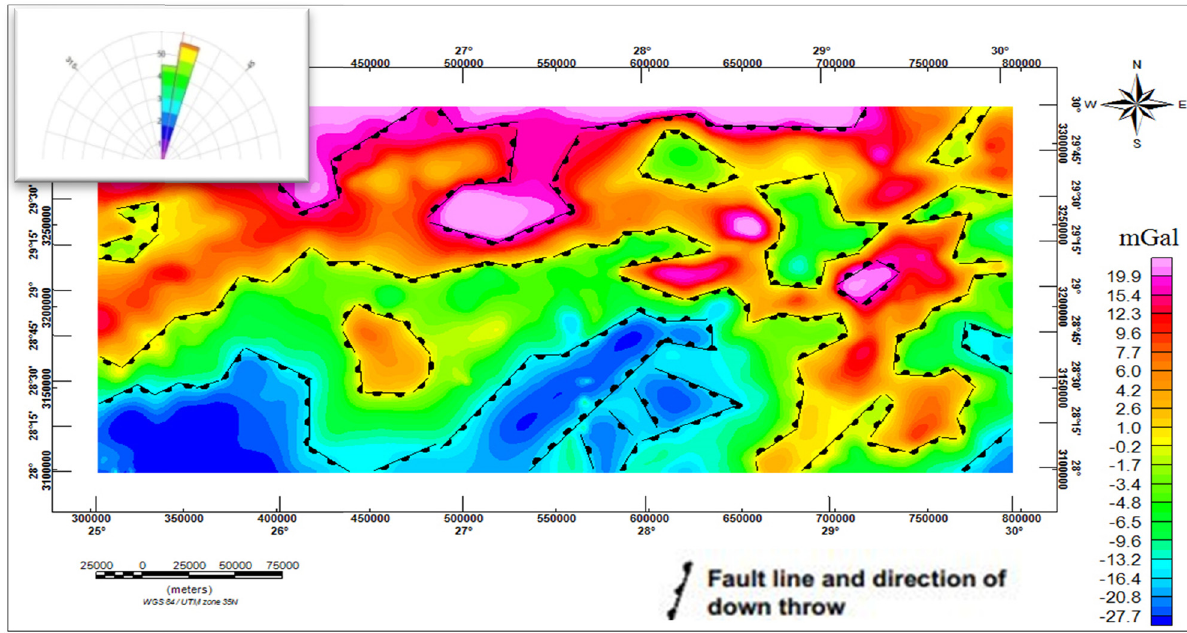
Figure 13: Gravity lineaments and corresponding azimuth frequency diagram.